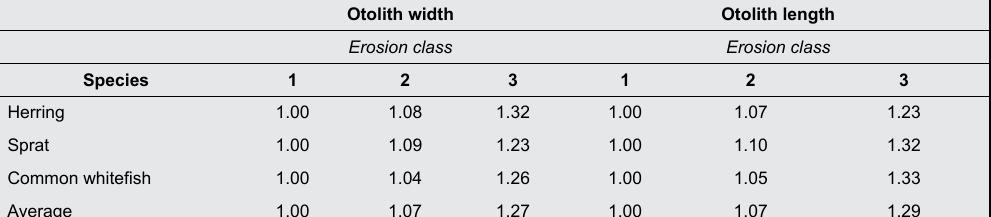
Table 5. Species and erosion class-specific size correction factors (SFCs) for the prey species herring, sprat and common whitefish and the average for the 3 species. Bold figures indicate the SCFs used in our